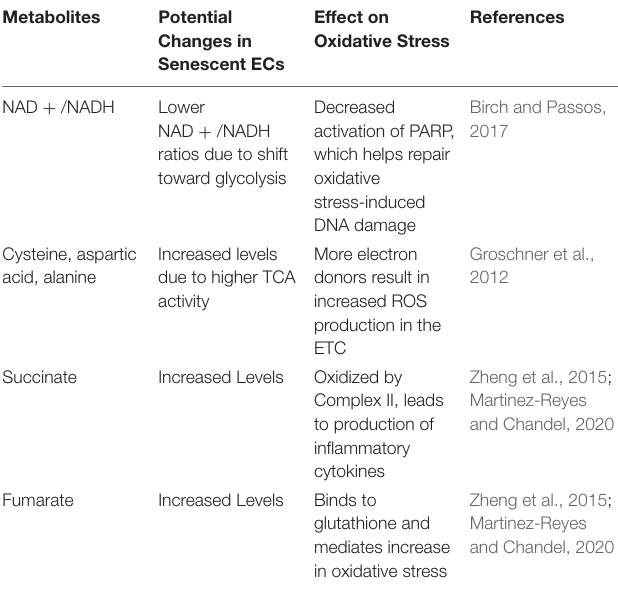
TABLE 1 | Role of metabolites in oxidative stress and mitochondrial